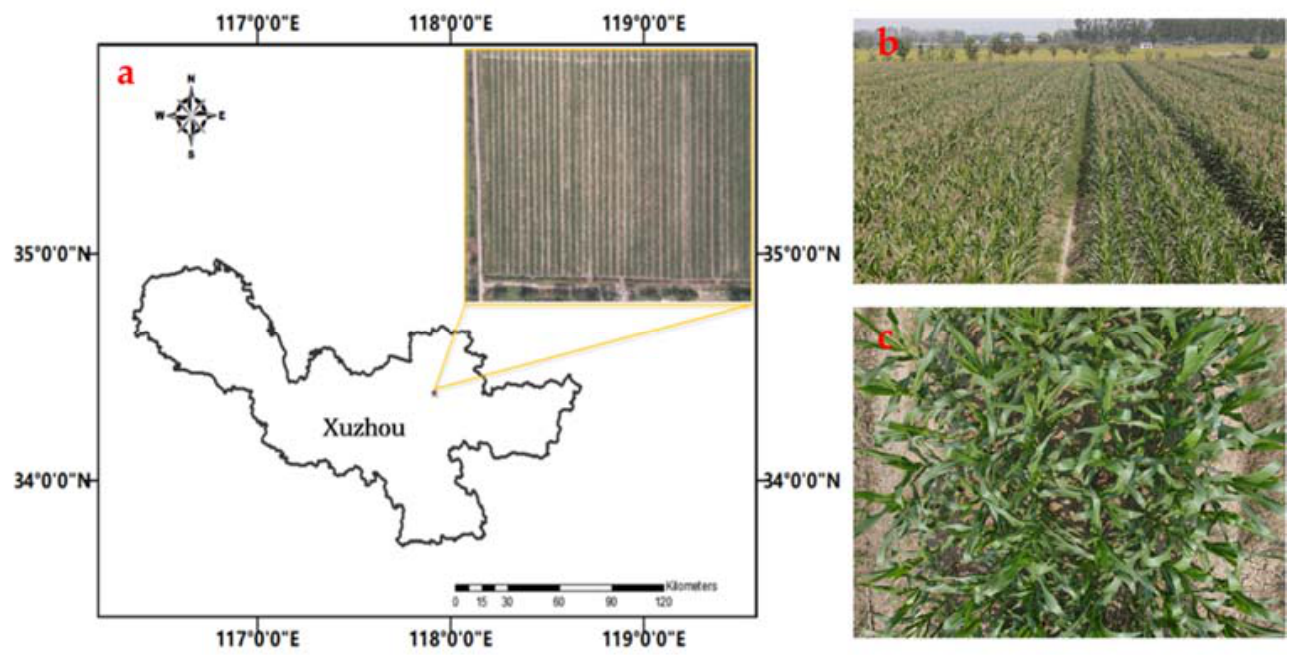
Figure 1. Sample location and example of collected data. ( a ) Location of study area and an aerial view from an altitude of 120 m. ( b ) Image of the study area. ( c ) Example of experimental image taken by UAV.